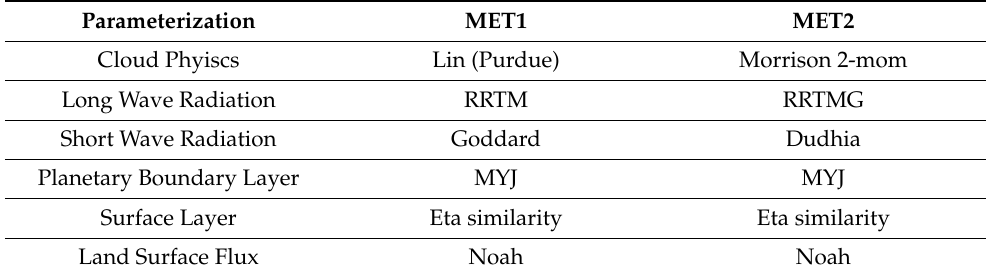
Table 1. Parameterized combination of WRF meteorological processes.